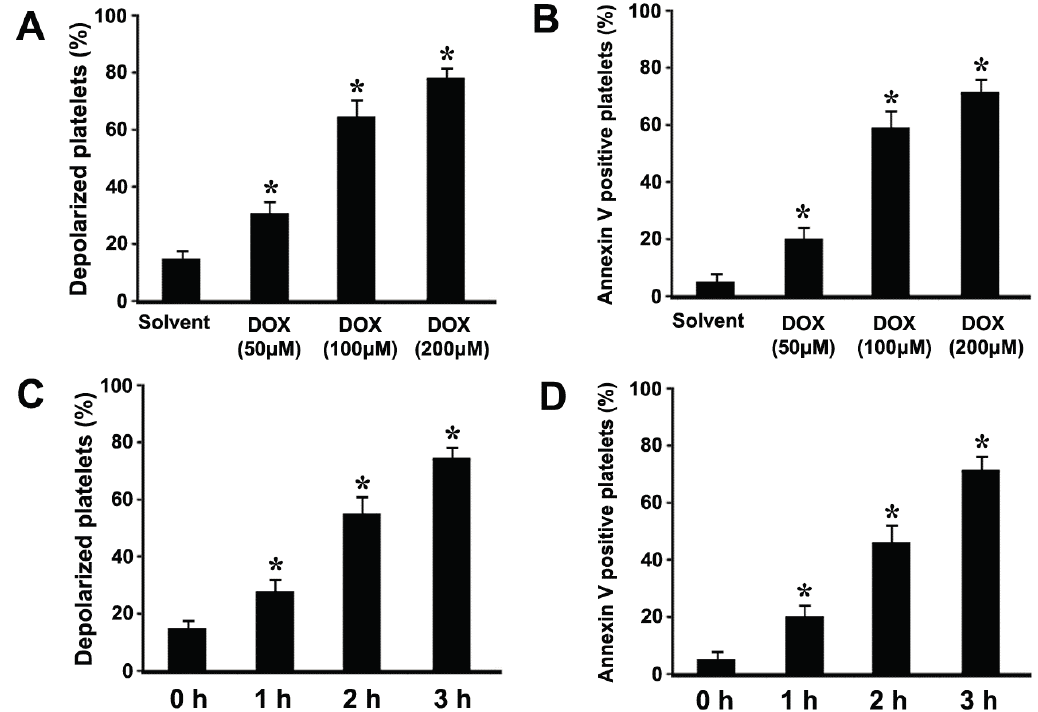
Figure 1. Doxorubicin (DOX) induced mitochondrial inner transmembrane potential ( ΔΨ m) depolarization and PS exposure. ( A – D ) Platelets were incubated with different concentrations of DOX or solvent control ( A , B ), or incubated with DOX (200 μ M) at 37 °C for different times ( C , D ). Treated platelets were incubated with tetramethylrhodamine ethyl ester (TMRE) ( A , C ), or fluorescein isothiocyanate (FITC)-conjugated annexin V ( B , D ), and analyzed by flow cytometry. ΔΨ m depolarization was quantified as the percentage of depolarized platelets. Means ± SEM from three independent experiments are shown ( A , C ). PS exposure was quantified as the percentage of PS positive platelets. Means ± SEM of the percentage of PS positive platelets from three independent experiments are shown ( B , D ). * p < 0.017 (after a Bonferroni correction) compared with solvent